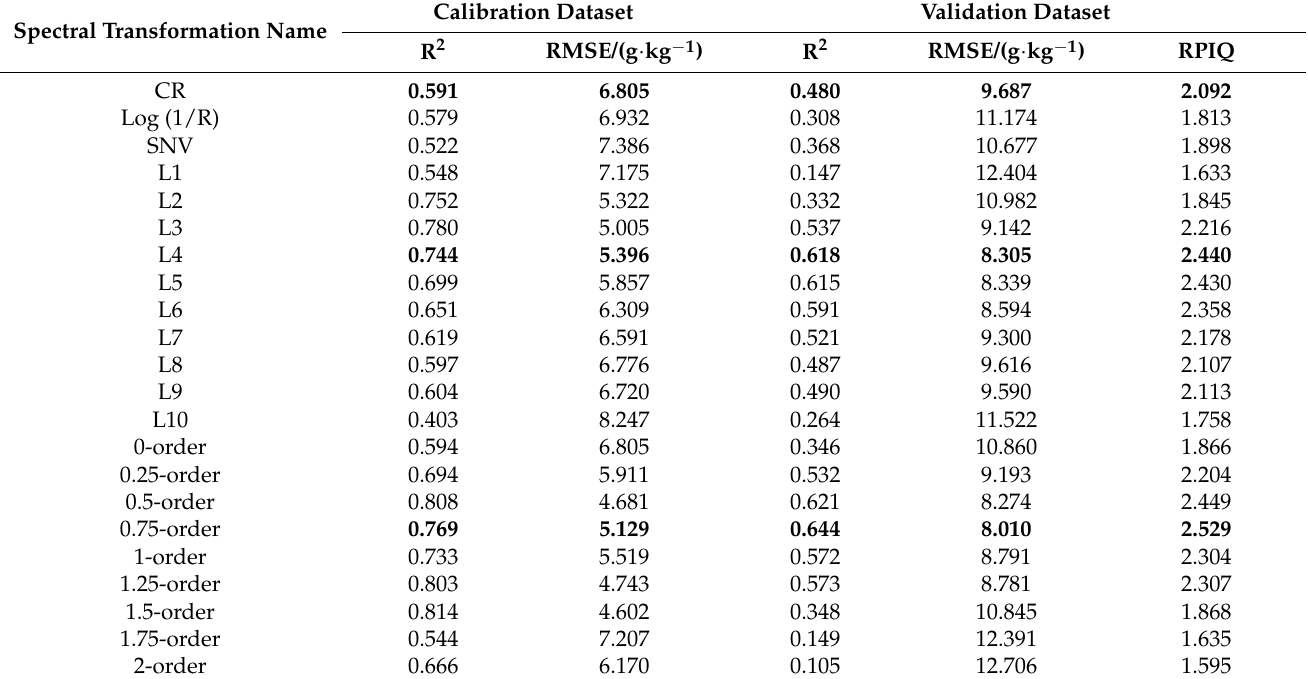
Table 6. The results of the SVR estimation of soil iron oxide content using the full spectrum.